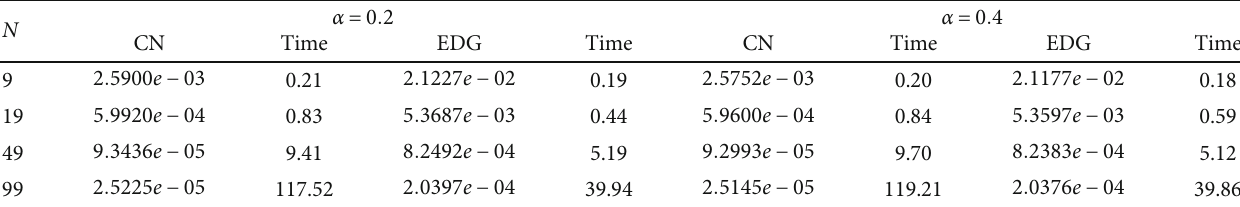
Table 7: Absolute errors of Example 16 at T = 1 for Re = 2 , Δ t = 0 : 01 , α = 0 : 2 , and α = 0 : 4 .